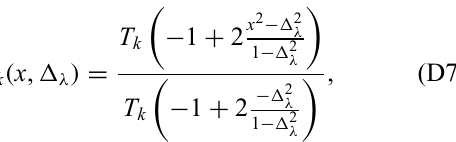
FIG. 28. The response function for a degree-18 polyno- mial approximation to the phase estimation function in the (cid:8) 0 | · | 0 (cid:6) ) convention. ( W x , S z ,